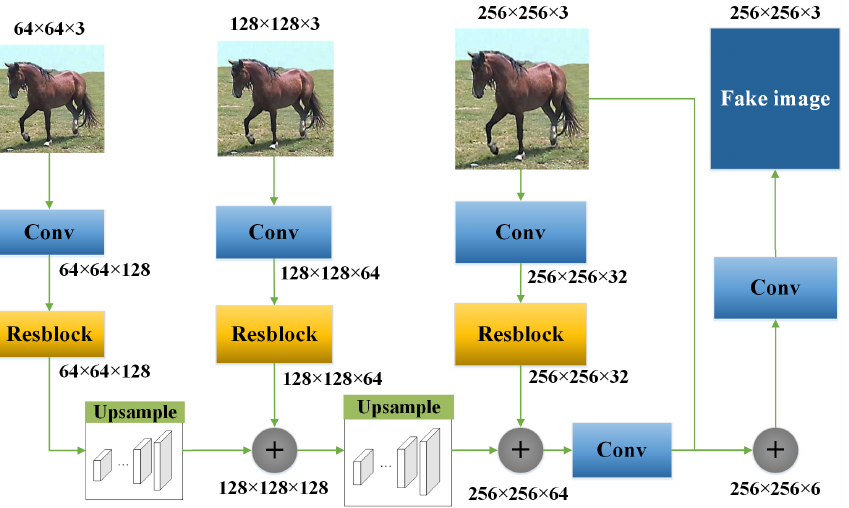
Figure 2. The generator network uses a multi-scale layered residual structure to preserve the details of images as much as possible, where three input scales of images are obtained by a bilinear interpolation method, combined with residual operators and convolutions for training the